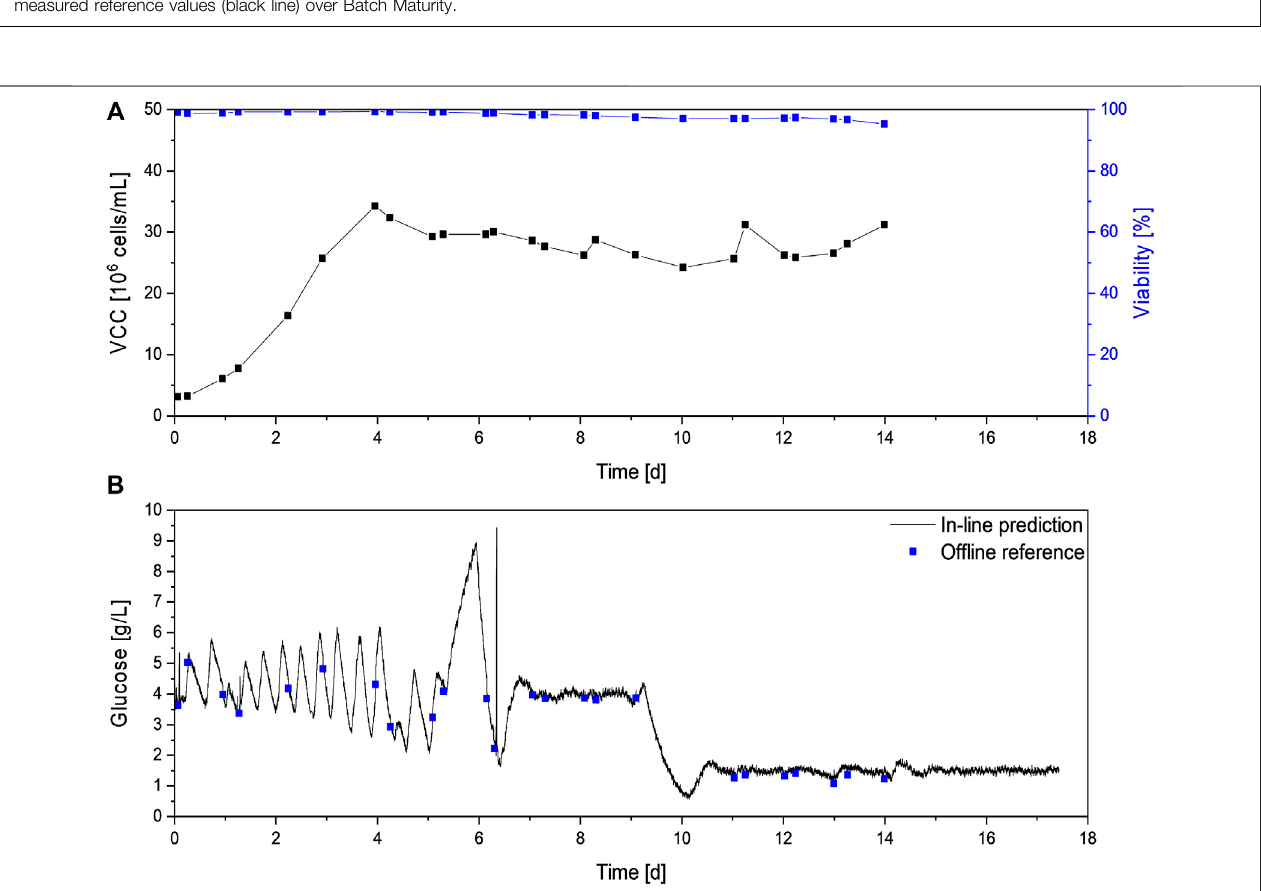
Frontiers in Bioengineering and Biotechnology |